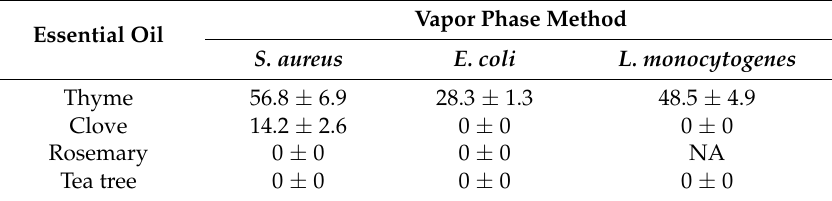
Table 5. Mean inhibition zone diameter (mm) by the vapor disc diffusion method.